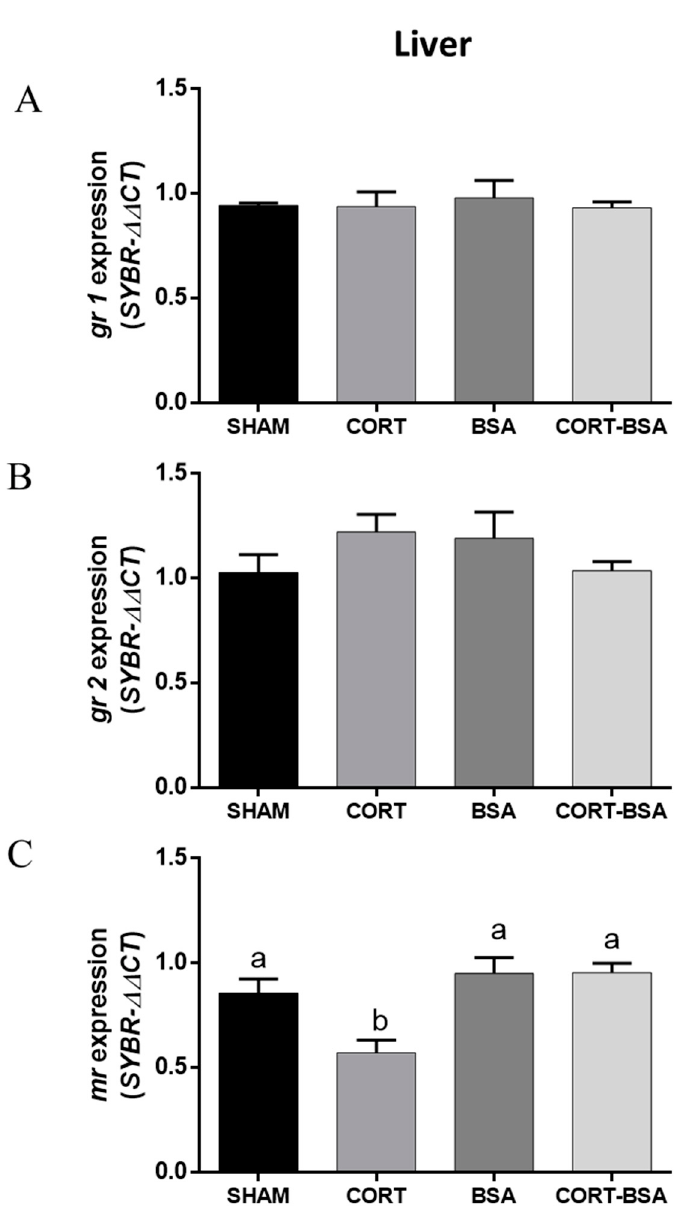
Figure 2. Corticosteroid-receptors gene expression in liver. Results of gr1 ( A ), gr2 ( B ) and mr ( C ) expression in vehicle (sham-control), cortisol, BSA and cortisol-BSA administered fish at 72 h post-treatment. Results are expressed as mean ± SEM ( n = 8). Different letters indicate significant differences between groups ( p value < 0.05). All data were analyzed using one-way ANOVA and Tukey’s HSD as a post hoc test.